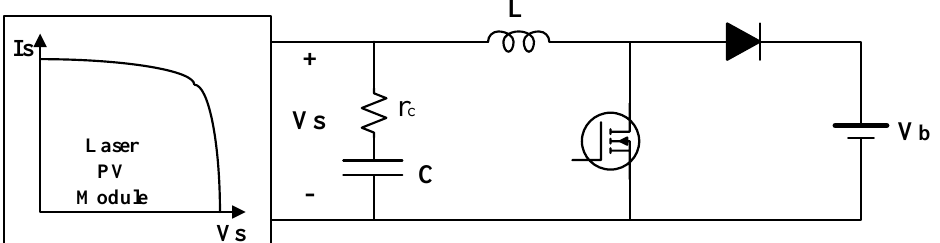
Figure 5. Boost converter for battery charging with laser PV module.